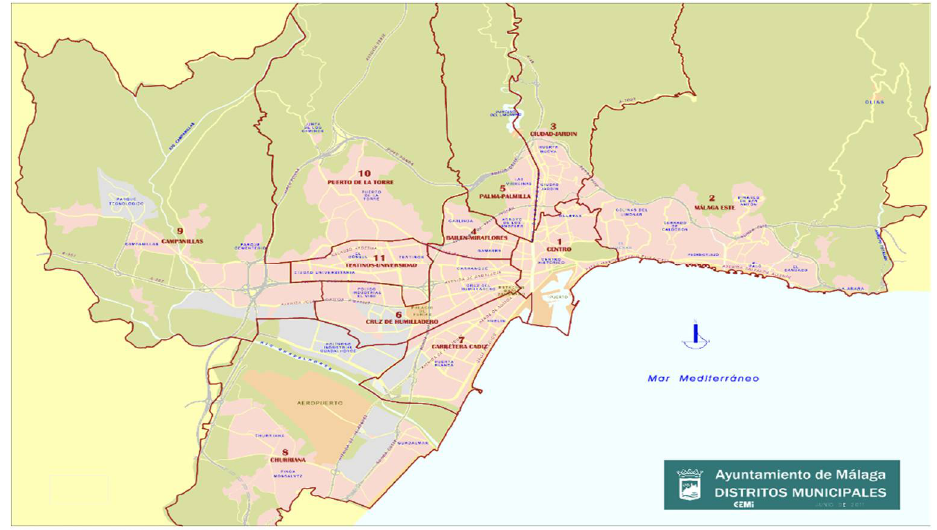
Figure 3. Map of municipal districts of Malaga. Source: Adapted with permission from ref. [83]. Copyright 2022 Ayuntamiento de Málaga.